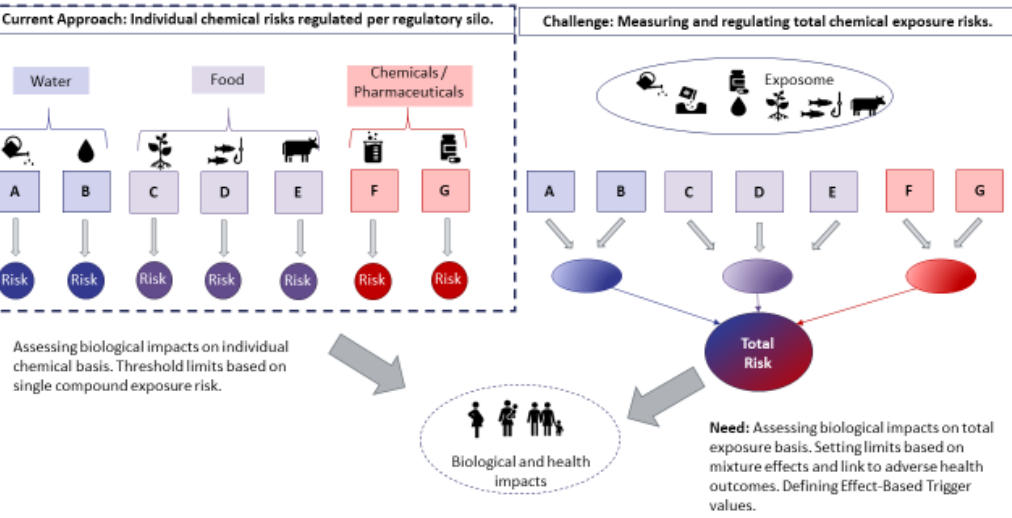
Figure 1. Current approach on chemical risk assessment and the challenge of mixture risk assessment addressed by PANORAMIX. The letters A–G refer to different compounds (modified from [2]).